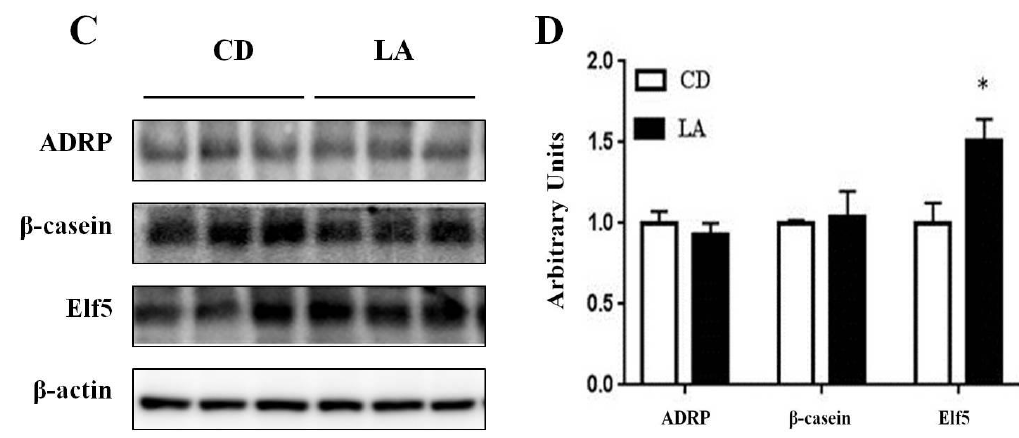
Figure 5. The e ff ects of 100 µ M LA on the content of TG and relative gene expressions in HC11 cells by DIP-induction. ( A ) The content of TG in HC11 cells and in the cell supernatant. ( B ) The relative mRNA expression level of FASN, PPAR γ , FATP4, and ACADM in HC11 cells by DIP-induction (n = 4). ( C ) Western blot analysis of ADRP, β -casein, and Elf5 in HC11 cells by DIP- induction. β -actin was used as the loading control. ( D ) Mean ± SEM of immunoblotting bands of ADRP, β -casein Elf5, the intensities of the bands are shown as arbitrary units (n = 4). CD is control group. * p < 0.05 versus control group.